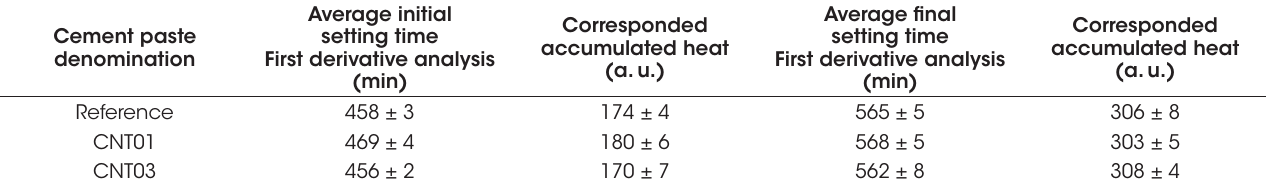
First derivative procedure: average initial and final setting times and corresponding evolved accumulated heat for each cement paste composition Cement paste